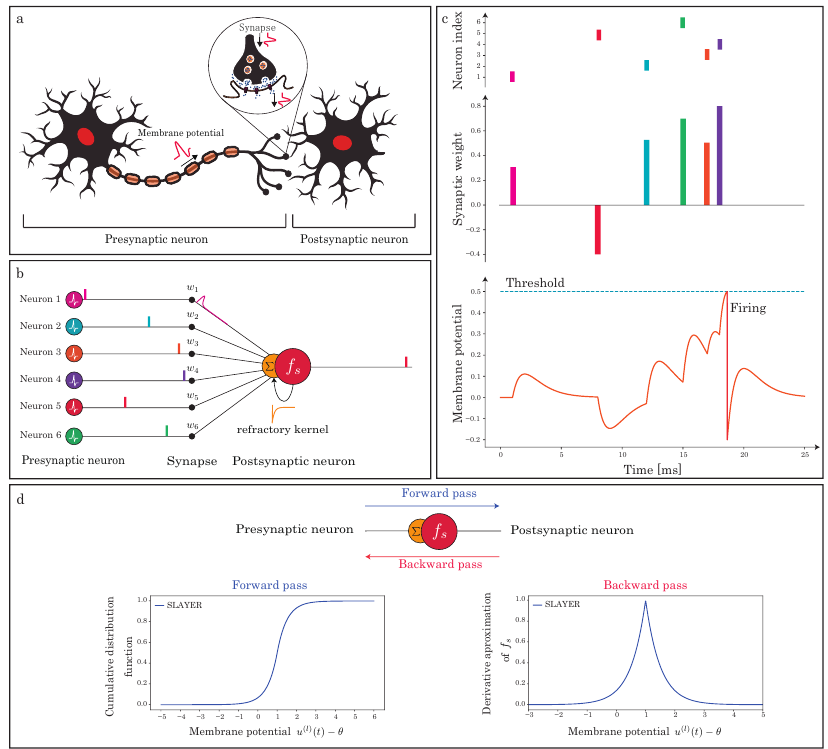
Figure 1. Illustration of fundamental components of SNN. ( a ) Biological information and signal pro- cessing between presynaptic and postsynaptic neurons in SNN. ( b ) A spiking neuron processes and communicates binary spiking events over time. ( c ) The postsynaptic neuron changes the membrane potential through each layer of the post-synaptic potential (PSP). It generates the output spikes when the membrane potential reaches the neuronal firing threshold [21]. ( d ) The cumulative distribution function (“Forward pass”) of our surrogate gradient and itself (“Backward pass”)